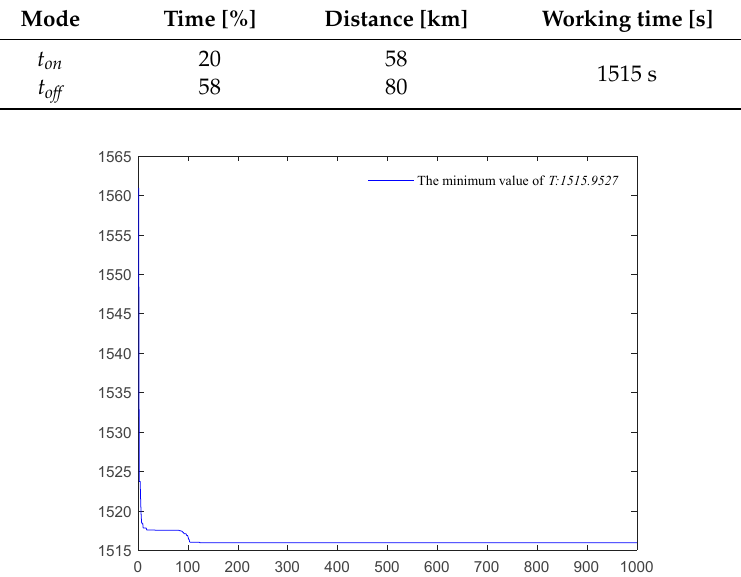
Table 9. Optimal on-off control mode.